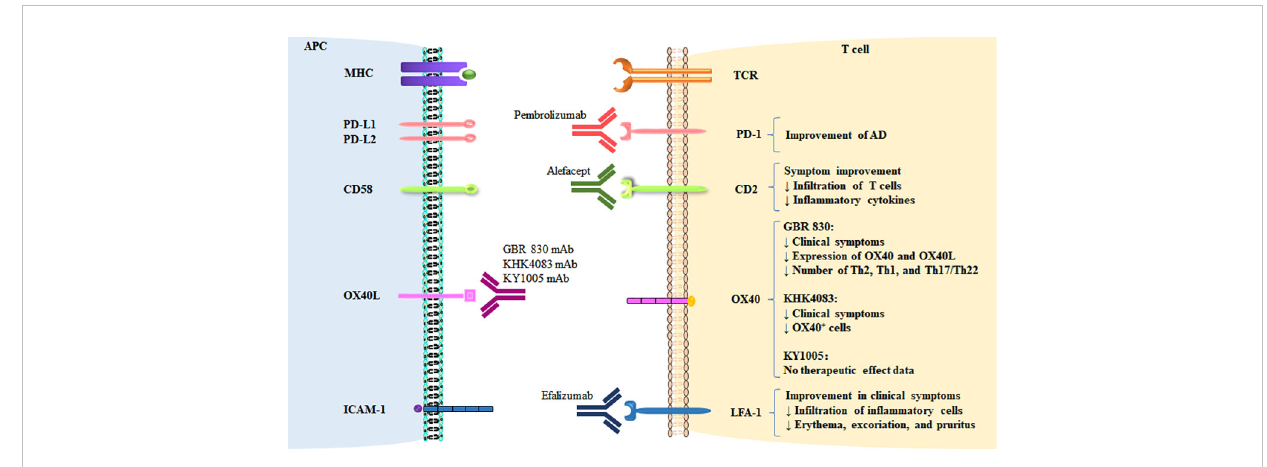
FIGURE 2 Therapeutic targeting of co-stimulatory and co-inhibitory pathways in AD. The targeting of co-signaling molecules in AD and therapeutic effects are shown.